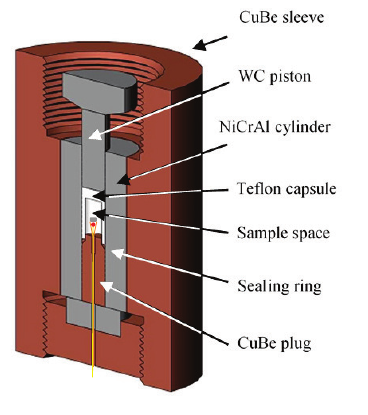
Figure 2: Ruby fluorescence spectra. The smaller and larger peaks correspond to the R2 and R1 transitions, respectively.